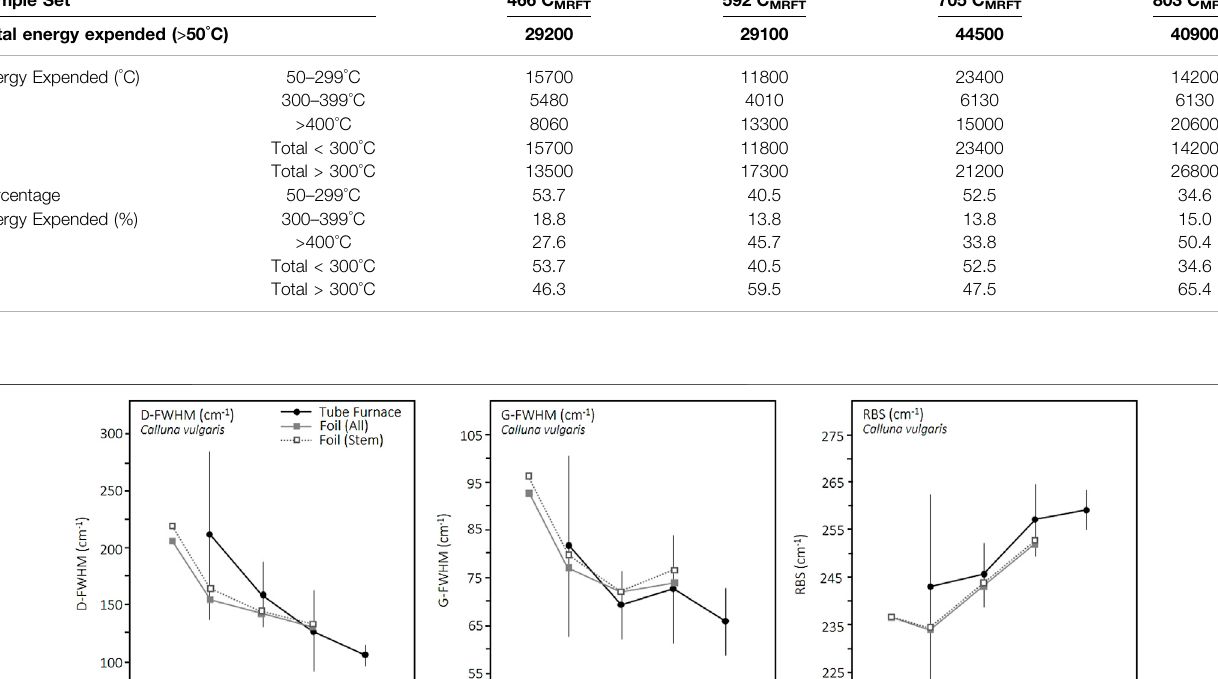
TABLE 2| Table highlighting thetotal energy generated within each prescribed fi re site, related to keythresholdsin mortality ( > 50 ° C), charcoali fi cation ( > 300 ° C), and fl aming combustion( > 400 ° C).Thesevalueshavealsobeenpresentedaspercentagesoftotalenergyoutputexceedingmortalitythresholds.Allvaluesarederivedapproximately from the calculated area under time-temperature curves ( Figure 4 ) and reported to three signi fi cant fi gures. Sample Set